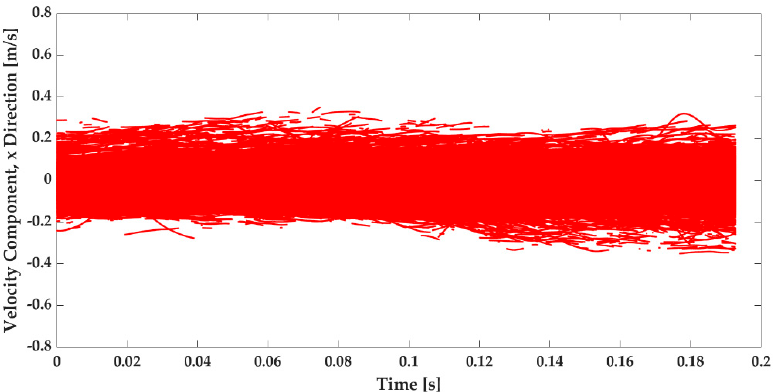
Figure 6. Velocity component in x direction from twenty videos, which involves 40,000 frames extracted via Lagrangian-particle tracking technique.